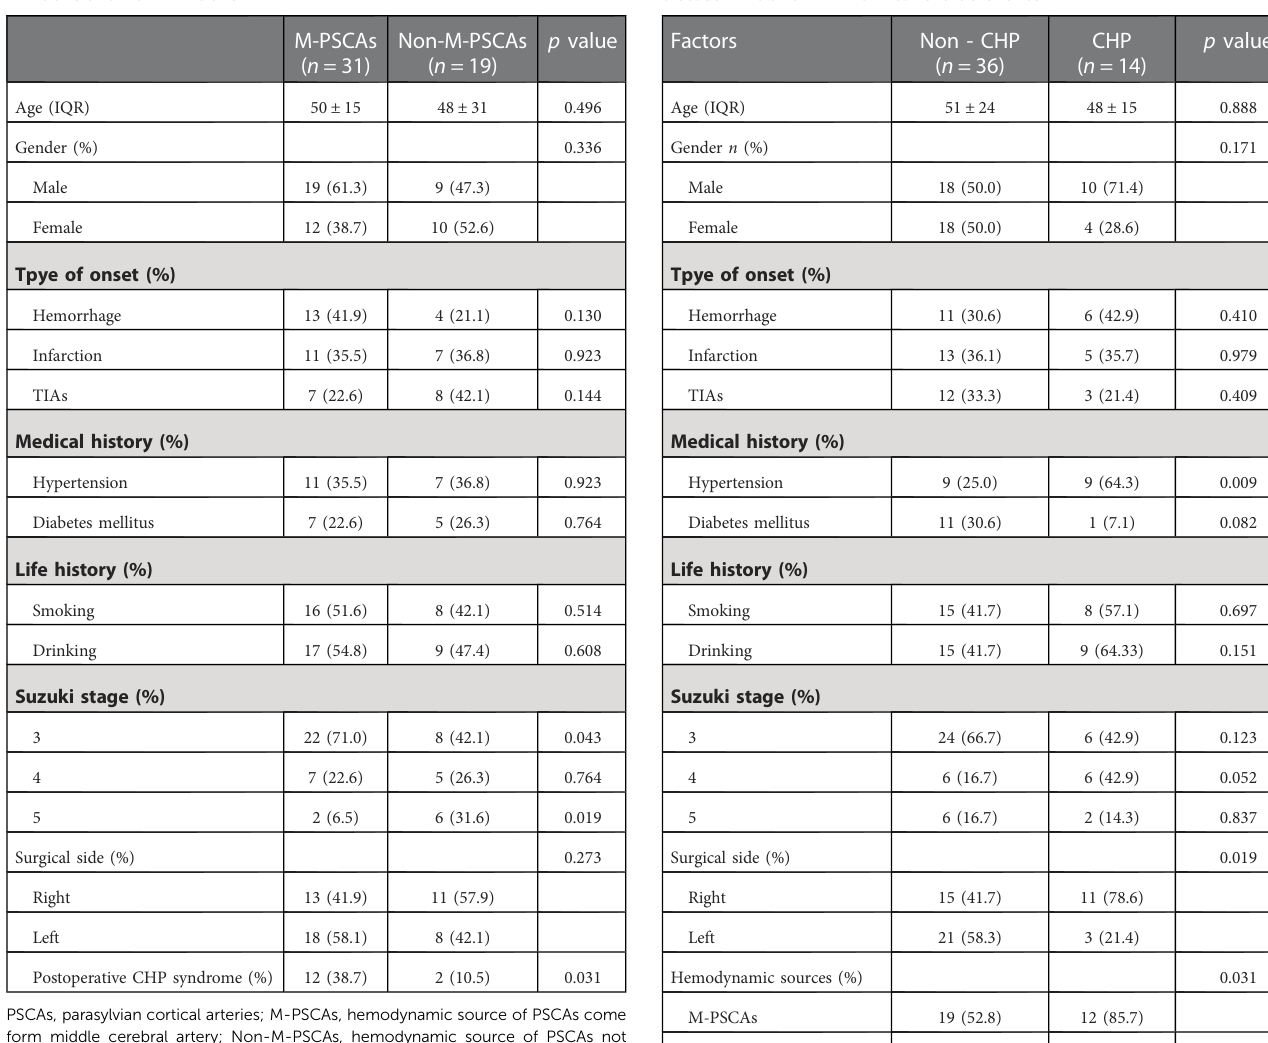
TABLE 1 Characteristics of the patients with moyamoya disease between M-PSCAs and non-M-PSCAs.